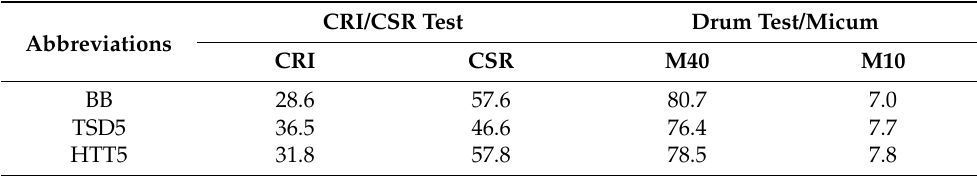
Table 10. Quality of coke prepared at technical